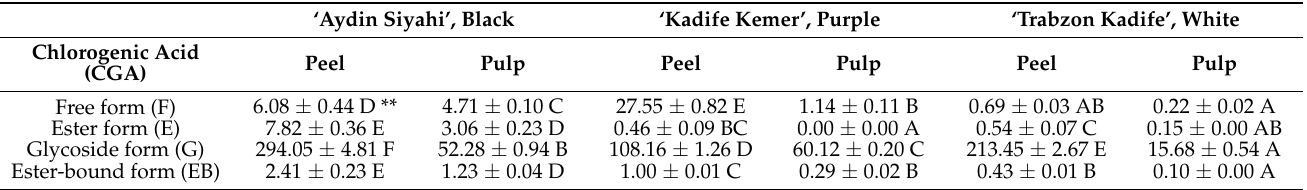
* Values represent the mean ± SD of three independent extractions and determinations. ** different capital letters in each row differ significantly at p < 0.05 (one-way ANOVA was used for